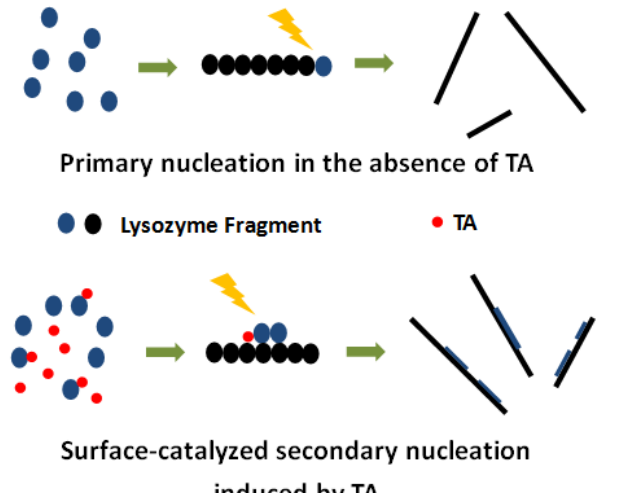
Figure 5. Schematic illustration of tannic acid-induced surface-catalyzed secondary nucleation.